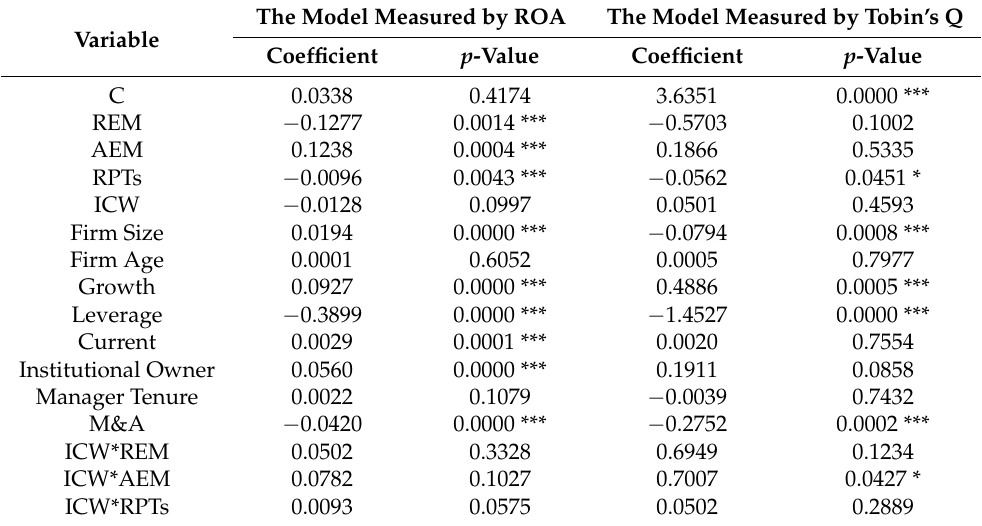
Table 6. The results of the first